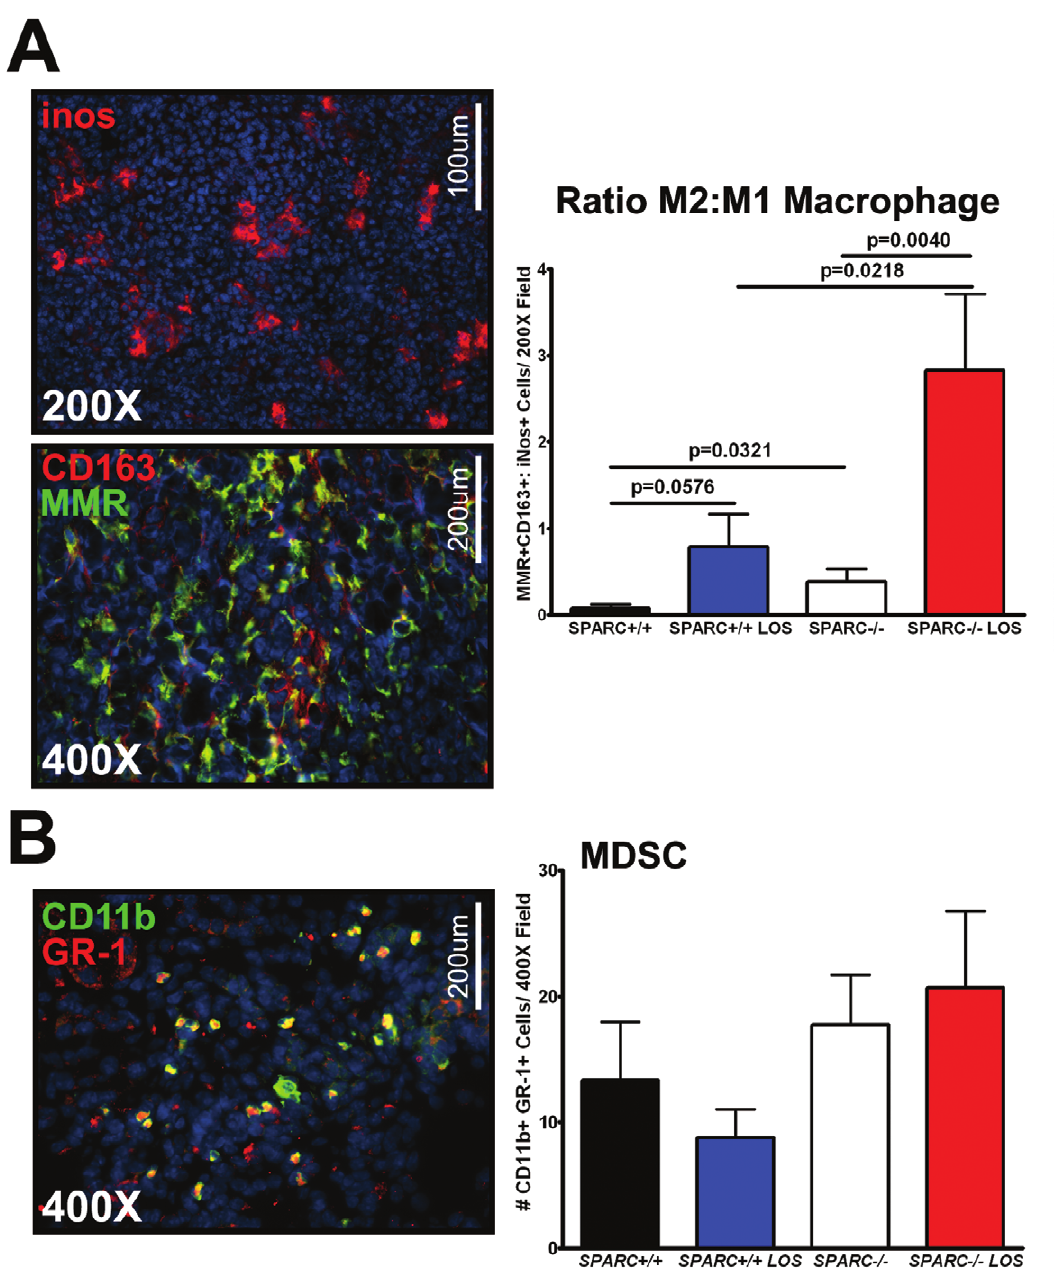
Figure 6. Losartan does not decrease macrophage and MDSC infiltration. Fluorescence immunohistochemistry was utilized to assess macrophage and myeloid derived suppressor cell (MDSC) recruitment in tumors grown in Pan02 orthotopic tumors grown in SPARC + / + and SPARC 2 / 2 mice treated with losartan (A–B). (A) Frozen tumor sections were stained with either antibody rabbit anti inos (red) for detection of M1 macrophage or antibody rabbit anti CD163 (red) and antibody rat anti MMR (green) for detection of M2 macrophage. DAPI (blue) marks cell nuclei. The number of inos positive cells and the number of CD163 and MMR double positive cells was counted and the ratio of M2 to M1 calculated. Total magnification (200 6 , 400 6 ) and scale bars (100 m m, 200 m m) are indicated. (B) Frozen tumor sections were stained with antibodies FITC-conjugated rat anti CD11b (green) and CY3-conjugated rat anti GR-1 (red). DAPI (blue) marks cell nuclei. The number of CD11b and GR-1 double positive cells was counted. Total magnification (400 6 ) and scale bars (200 m m) are indicated. All p-values were calculated with the Student’s t test.